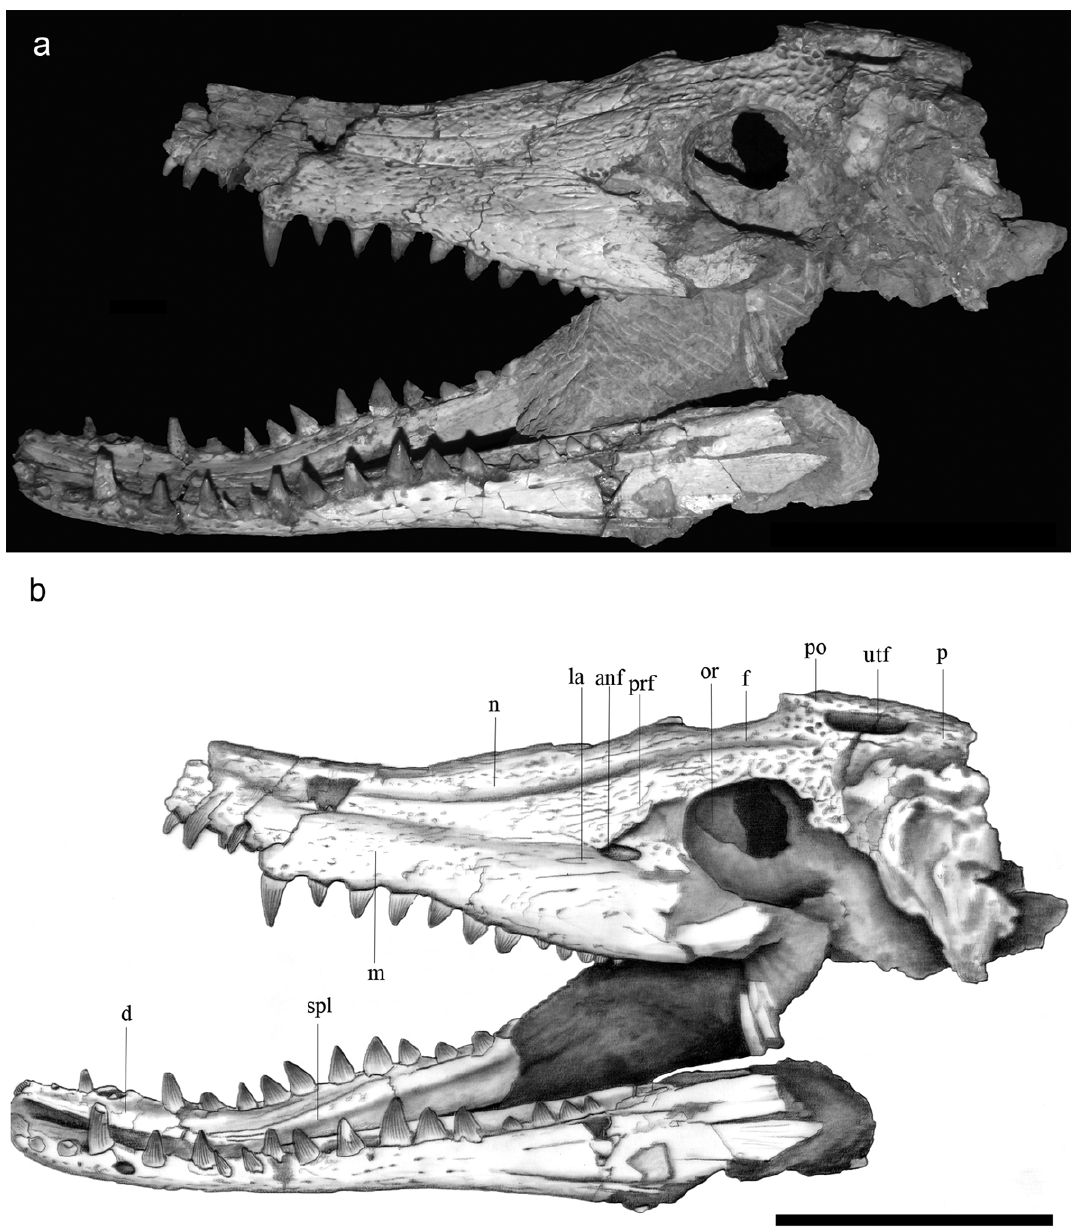
Fig. 2 – Lateral view of skull and mandible of the holotype (MN 7005 – V) of the crocodyliform Pepesuchus deiseae gen. et sp. nov. Scale bar: 100 mm. Abbreviations: anf – antorbital fenestra, d – dentary, f – frontal, la – lacrimal, m – maxilla, n – nasal, or – orbit, p – parietal, po – postorbital, prf – prefrontal, spl – splenial, utf – upper temporal